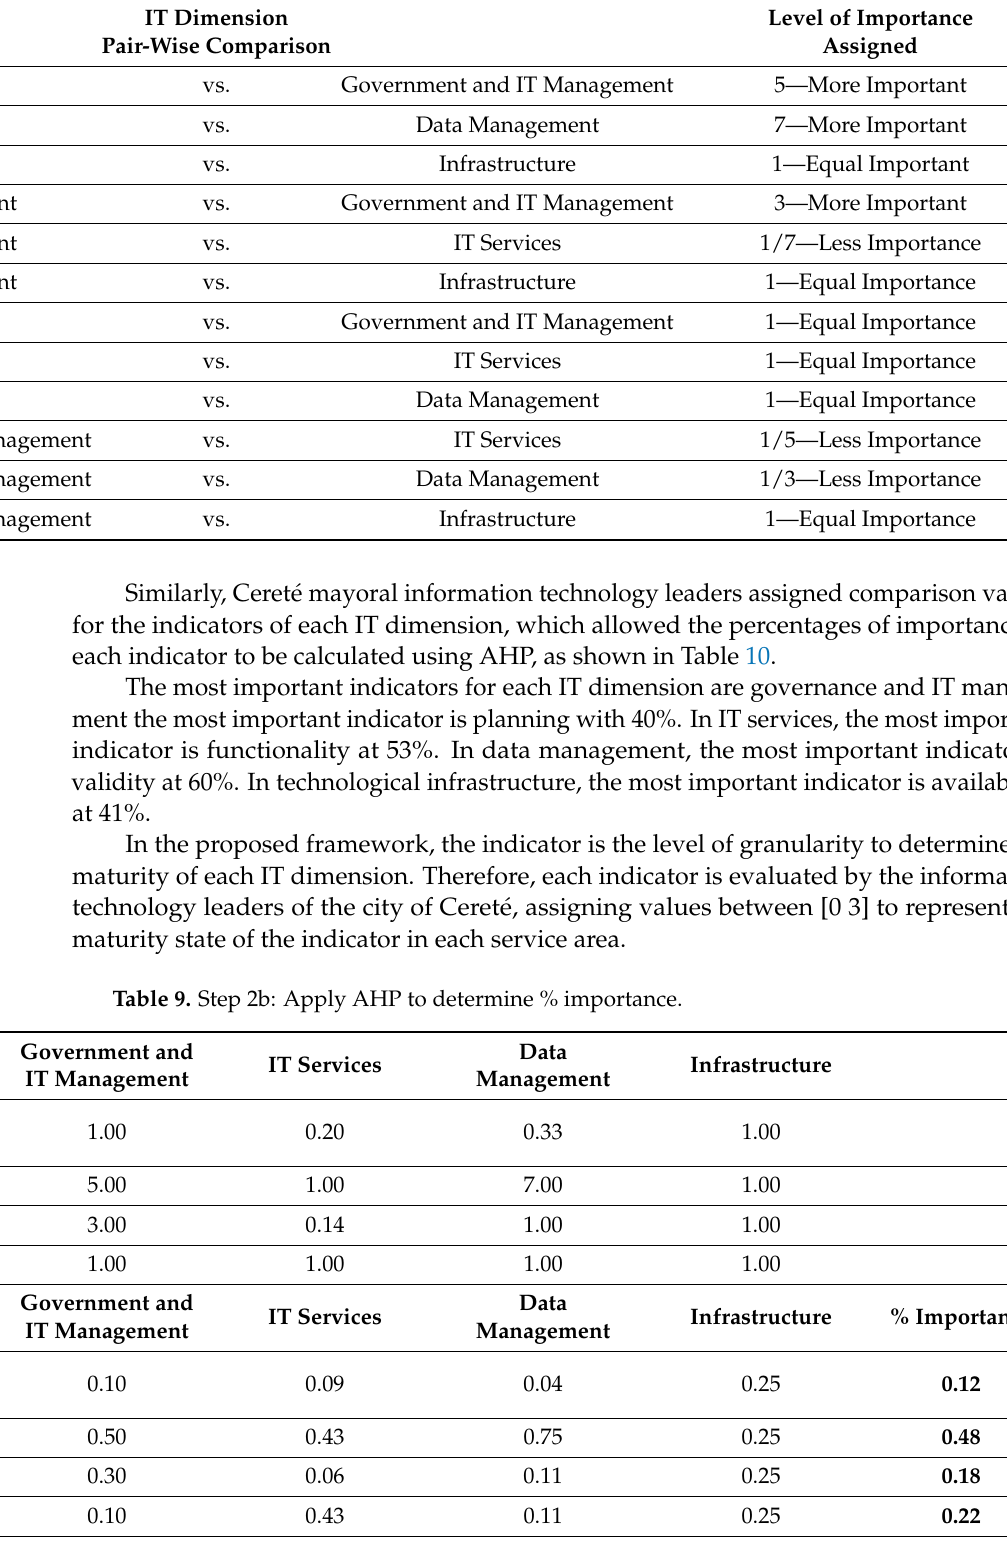
Table 8. Step 2a: Determine the importance of the IT dimensions.